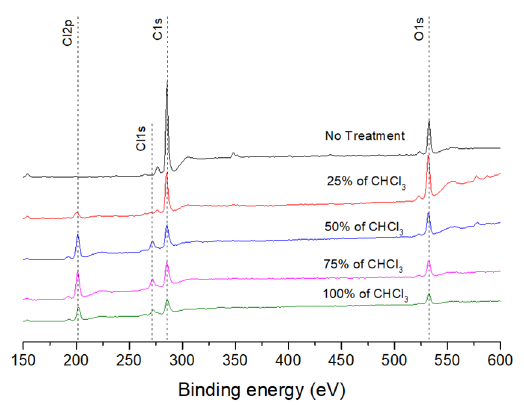
Figure 5. XPS survey spectra of the untreated and treated polyethylene.